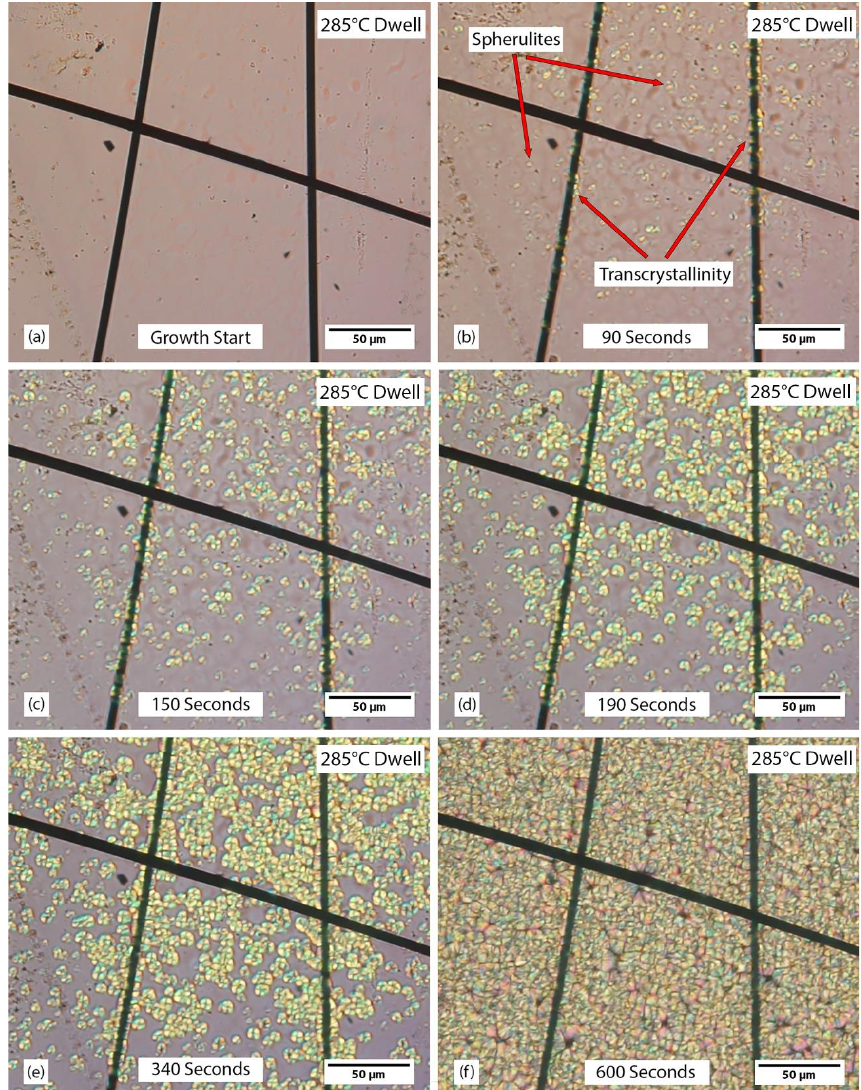
Figure 4. Time lapse growth of spherulites and transcrystallinity during a 285 °C dwell ( a ) molten polymer ( b ) nuclei start forming in the bulk polymer and from the fibers. ( c , d ) growth continues ( e ) transcrystallinity stops growth ( f ) visible growth stops.